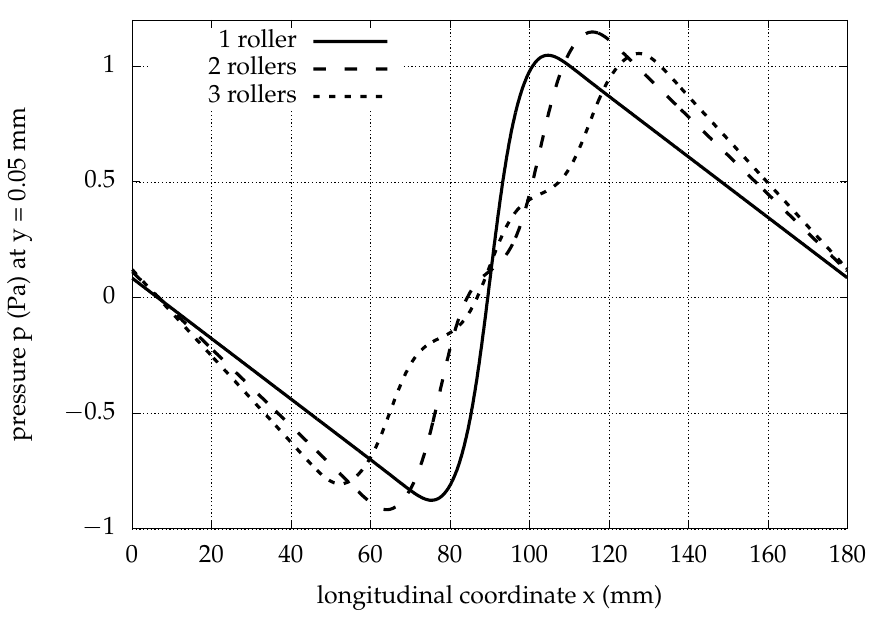
Figure 17. Pressure near the central axis of the pump ( y = 0.05 mm) for various numbers of rollers, c = 5 mm/s, RO = 0.6 and n = 1.